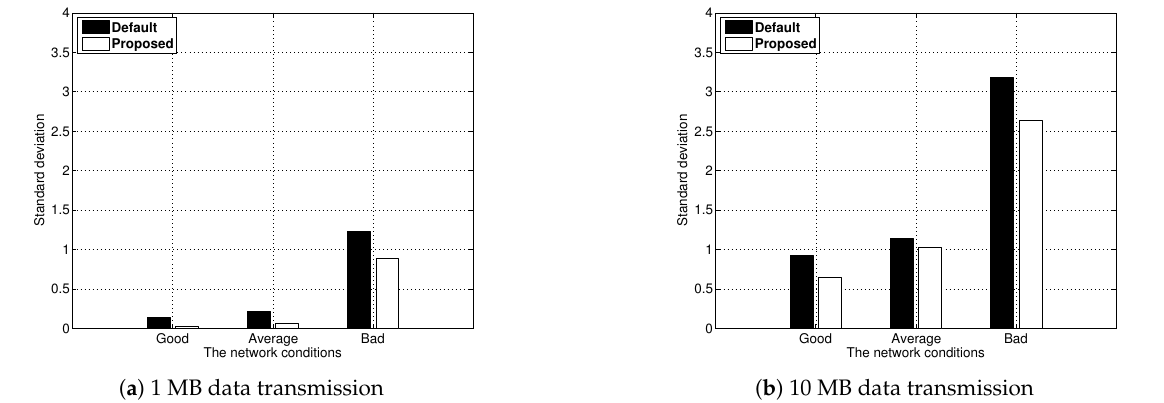
Figure 10. Latency standard deviation values for different network conditions with simple topology. ( a ) 1 MB and ( b ) 10 MB data transmission.